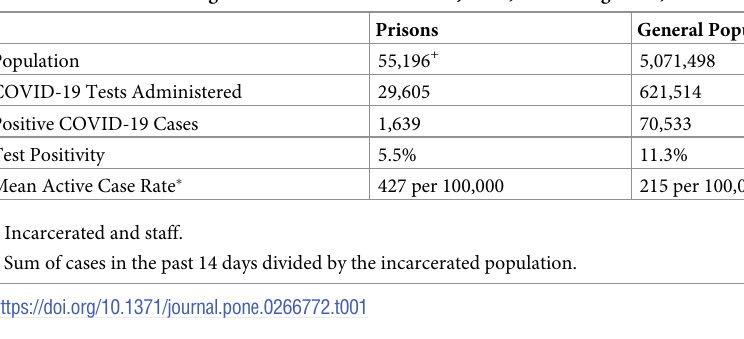
Table 1. COVID-19 testing and cases in North Carolina June 1, 2020—August 31, 2020.